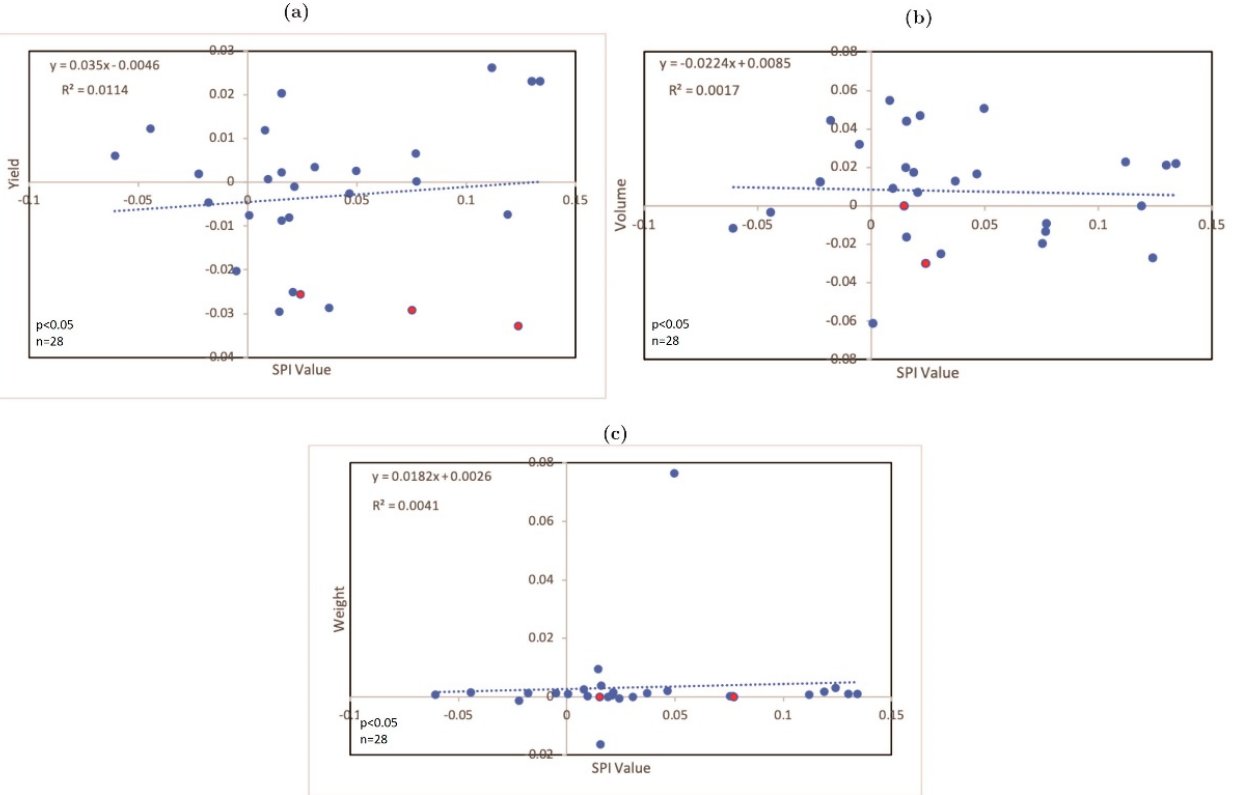
Figure 5. Behavior of the dispersion of ANSPIR average values and the analysis variable. ( a ) ANSPIR vs. corn crop yield, ( b ) ANSPIR vs. livestock cattle volume, and ( c ) ANSPIR vs. livestock cattle weight. Red points indicate the municipalities with a 95% statistical significance level. The dotted lines represent the trend of the scatter plot.